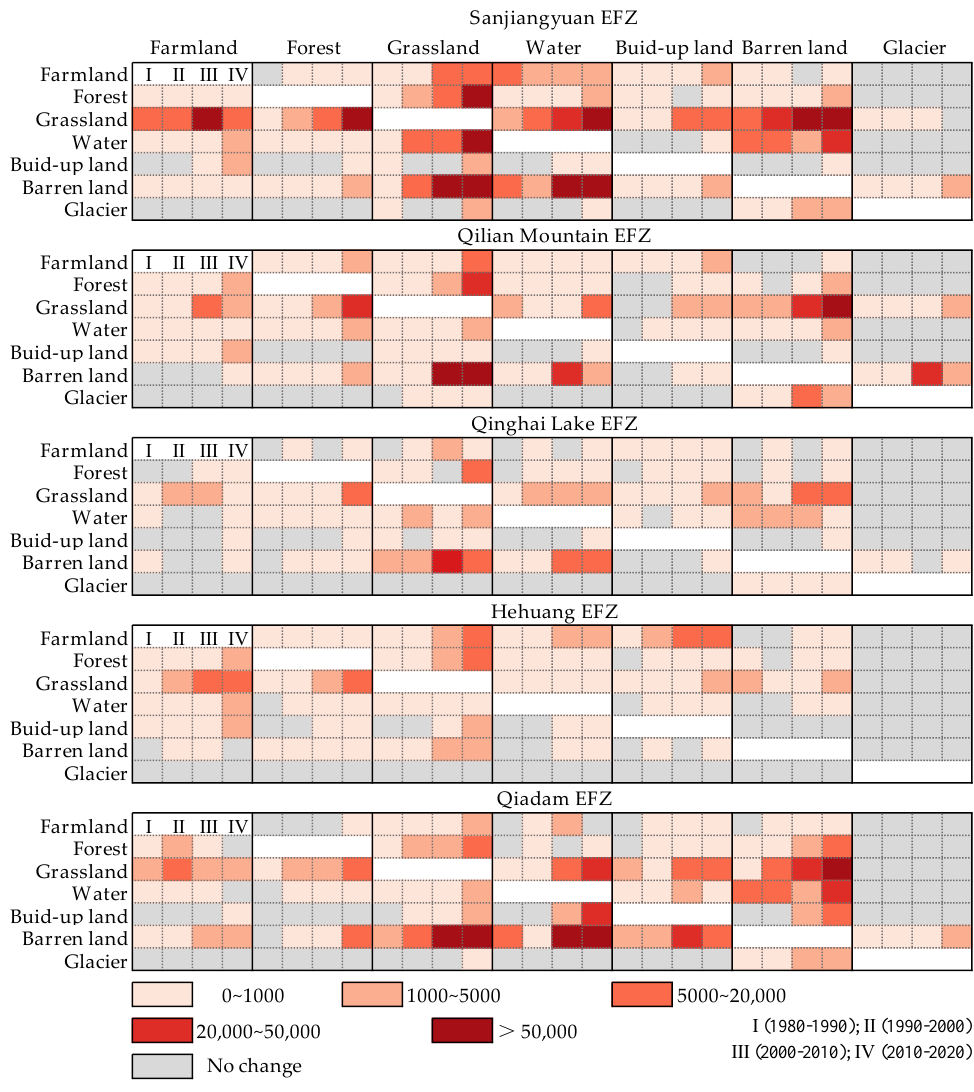
Figure 3. Land use type conversion in five EFZs in 1980 to